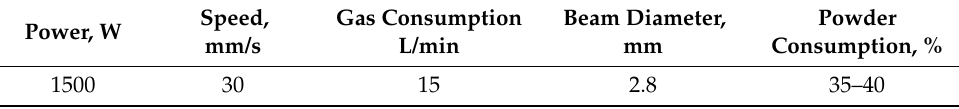
Table 1. Technological parameters of the Ti-6Al-4V DLD process. Power,